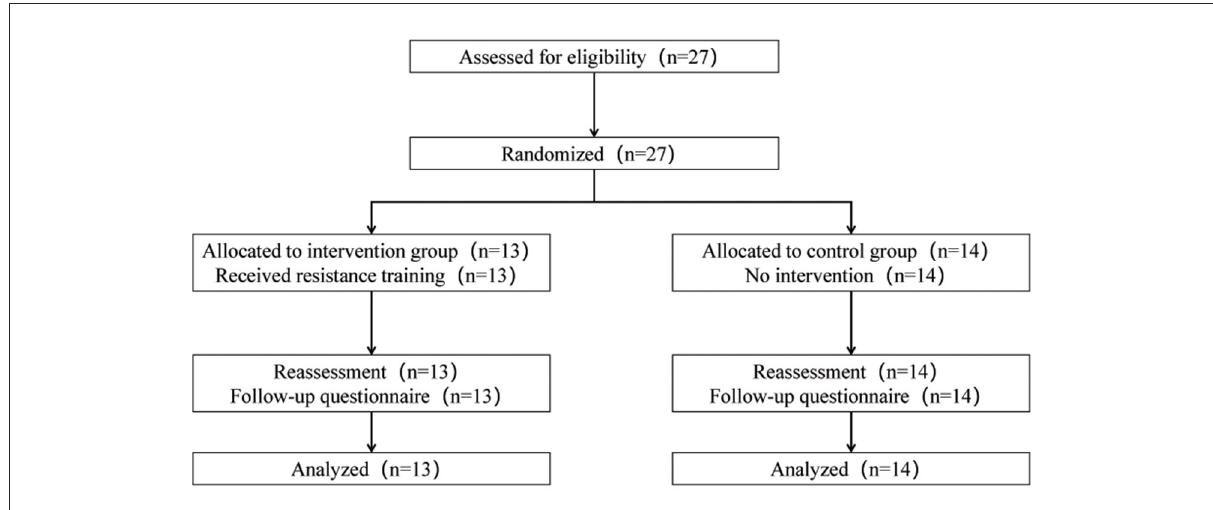
FIGURE1 The flow of participants through the